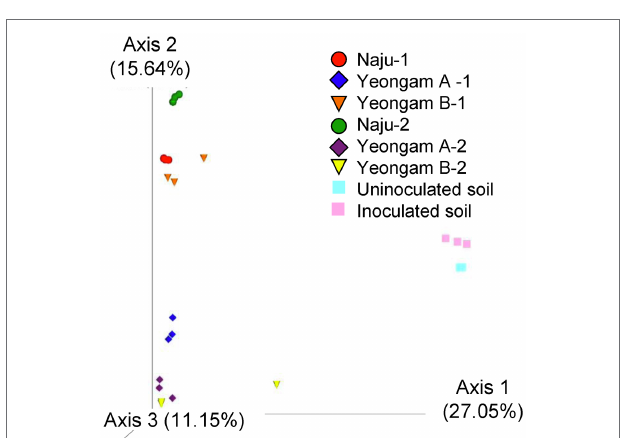
FIGURE 5 | Principal coordinate analysis (PCoA) based on Bray–Curtis dissimilarity of archaea, bacteria, and eukaryote (fungi) from the three fields— Naju, Yeongam A, and Yeongam B, and inoculated soil. Circle, Naju; Diamond, Yeongam A; cone, Yeongam B; Square, uninoculated and inoculated soil. 1 and 2 indicate before planting and harvest,